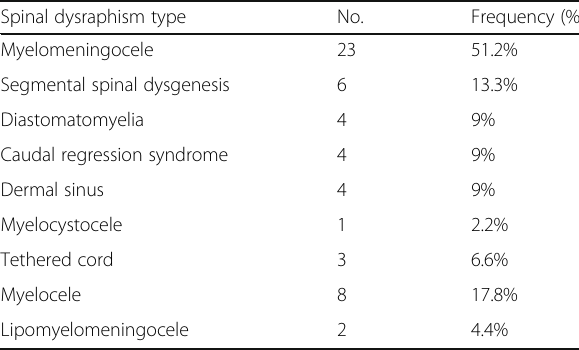
Table 3 Distribution of study population in terms of type of spinal